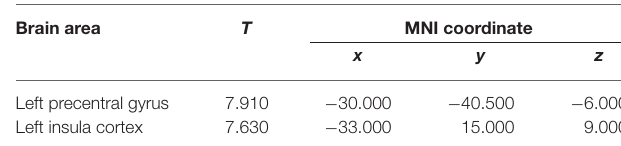
TABLE 3 | Brain area of OPVHs with significance in multivariate regression analyses.